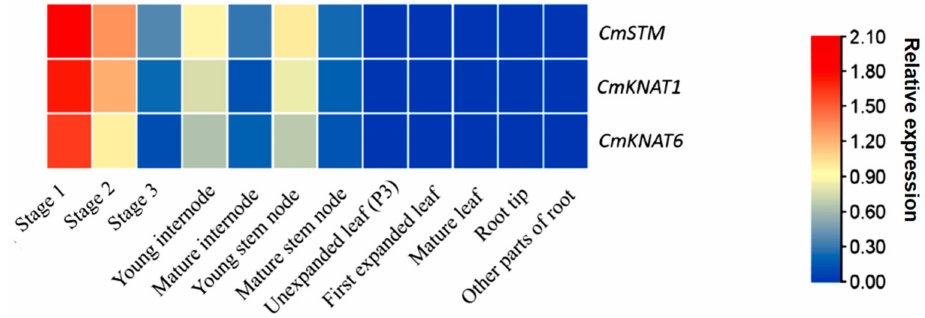
Figure 6. Analysis of the expression profile of these three KNOX genes of chrysanthemum at each stage of axillary bud development and each tissue part (Stage 1, Stage 2, and Stage 3 represent the early, middle, and late stages of chrysanthemum axillary bud formation, respectively. The data of each row in this figure has been normalized by the average value of the data of each row, that is, the average value of each row of data is set to